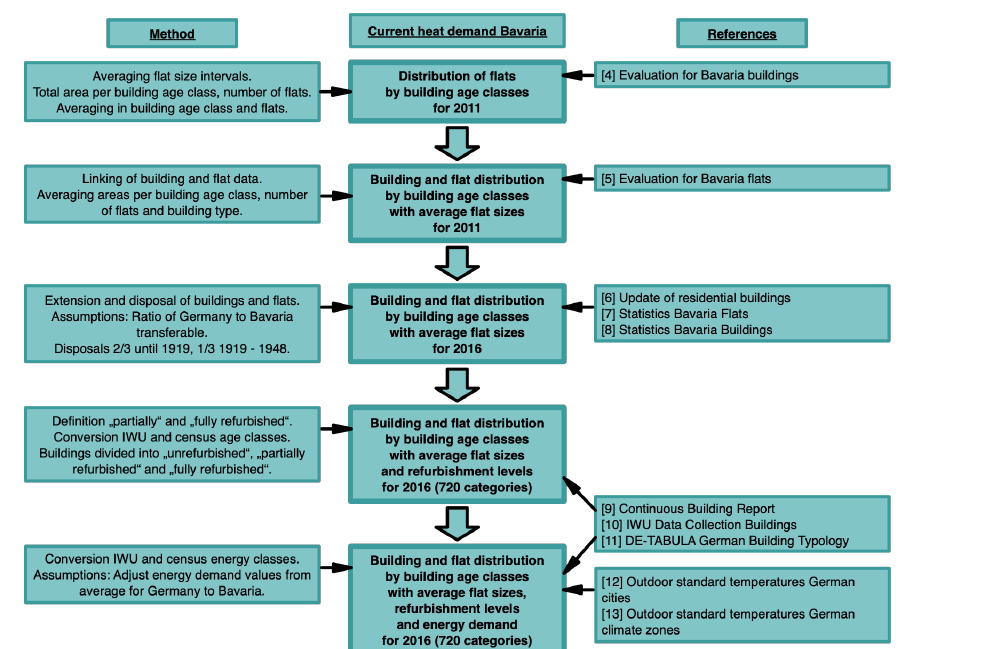
Figure 2. Balance heat demand residential buildings in Bavaria 2016. ([4], [5], [6–8], [9–11], [12, 13]).